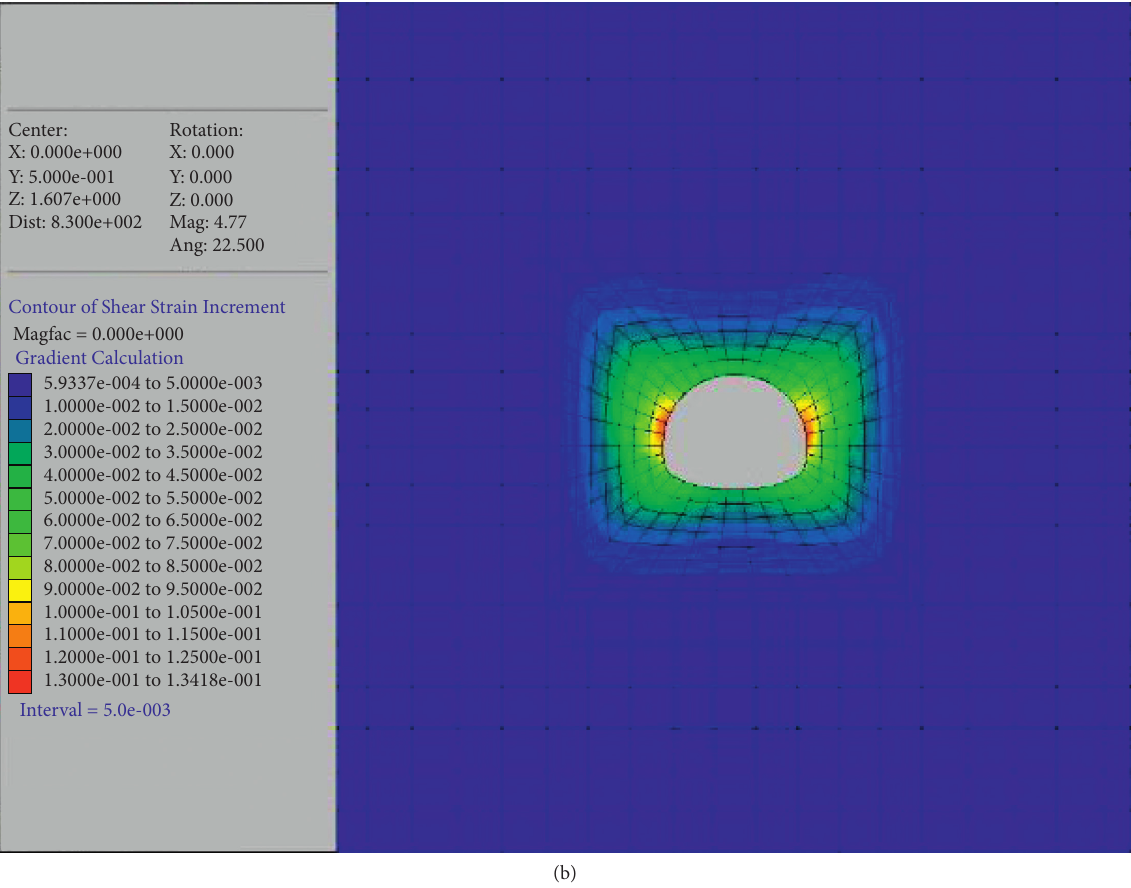
Figure 11: Numerical analysis results of the plastic zone radius of the surrounding rock in Jiangluling Macker Tunnel. (a) Distribution diagram of the plastic zone of the surrounding rock. (b) Distribution diagram of shear strain of the surrounding